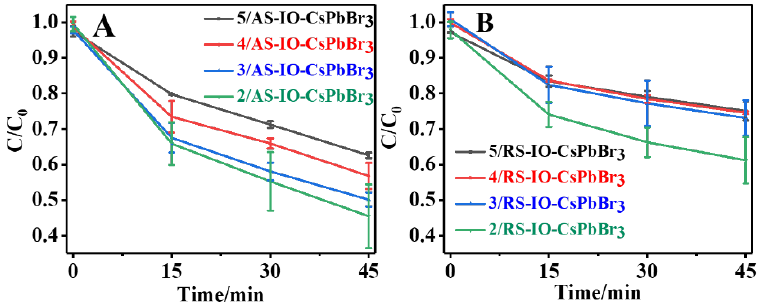
Figure 7. Time-dependent relative concentration of TerEDOT in the supernate in the presence of